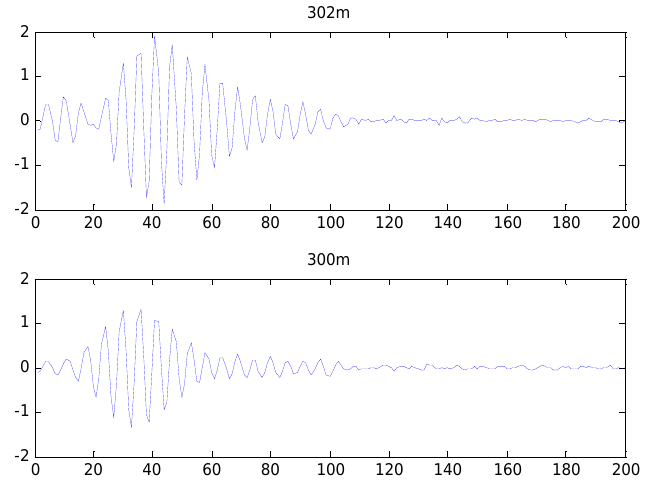
Figure 30. DCT coefficients of IMF 1 from records 300 m and 302